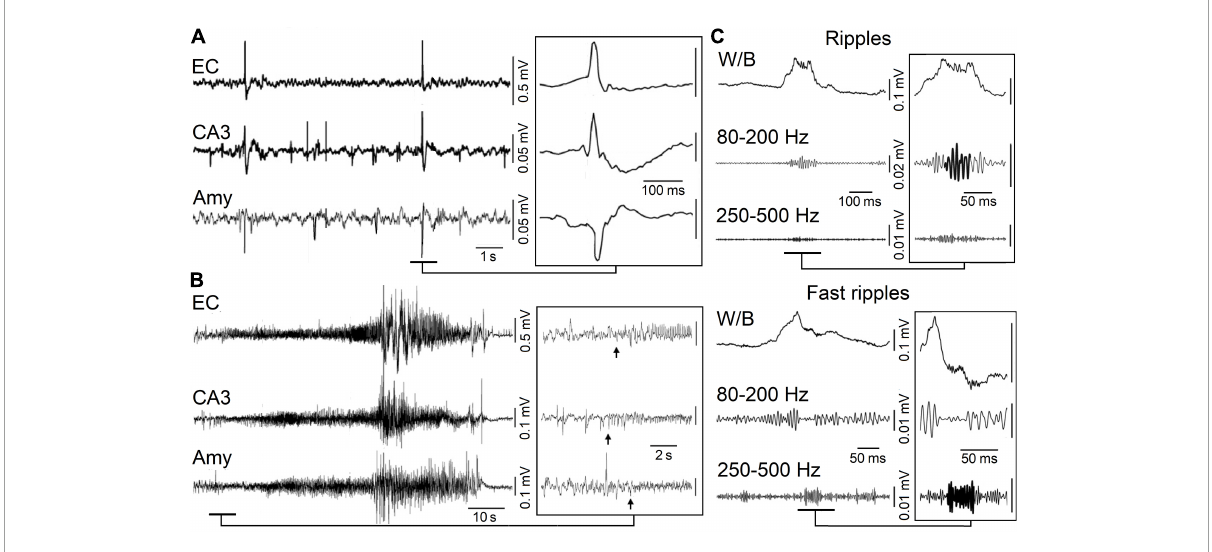
FIGURE1 (A) Spontaneous interictal discharges recorded from the entorhinal cortex (EC), the hippocampal CA3 region and the amygdala (Amy) in a pilocarpine-treated epileptic rat. Note that only two interictal spikes are present in all regions. (B) Spontaneous ictal (seizure) discharge recorded in a pilocarpine-treated epileptic animal from the same areas as in (A) ; low-voltage fast activity (arrows) marks the onset of this seizure. (C) High-frequency oscillations (HFOs, 80–500 Hz) recorded in association with interictal spikes in a pilocarpine-treated epileptic animal. Interictal spikes are visible on the wideband signal (W/B) whereas high-frequency activity is detectable only after filtering the signals between 80 and 200 Hz (Ripples) and between 250 and 500 Hz (Fast